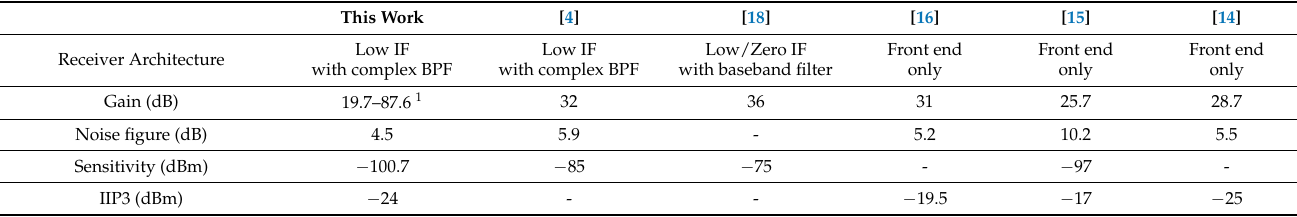
Table 1. Performance summary and